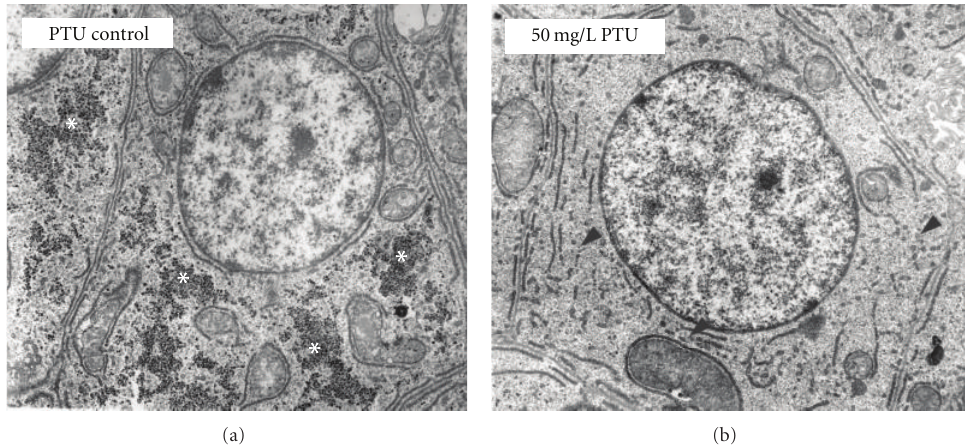
Figure 13: Representative ultrastructural alterations in hepatocytes of control (a) and PTU-exposed zebrafish (b). In the control fish, glycogen storage deposits are clearly visible ((a): ∗ ), whereas the exposed fish hardly display any glycogen in the cytoplasm. Moderate reductions and fenestrations of the rough endoplasmic reticulum are observable in PTU-exposed zebrafish ((b): (cid:2) ). Furthermore, the number of mitochondria is decreased. Magnification: